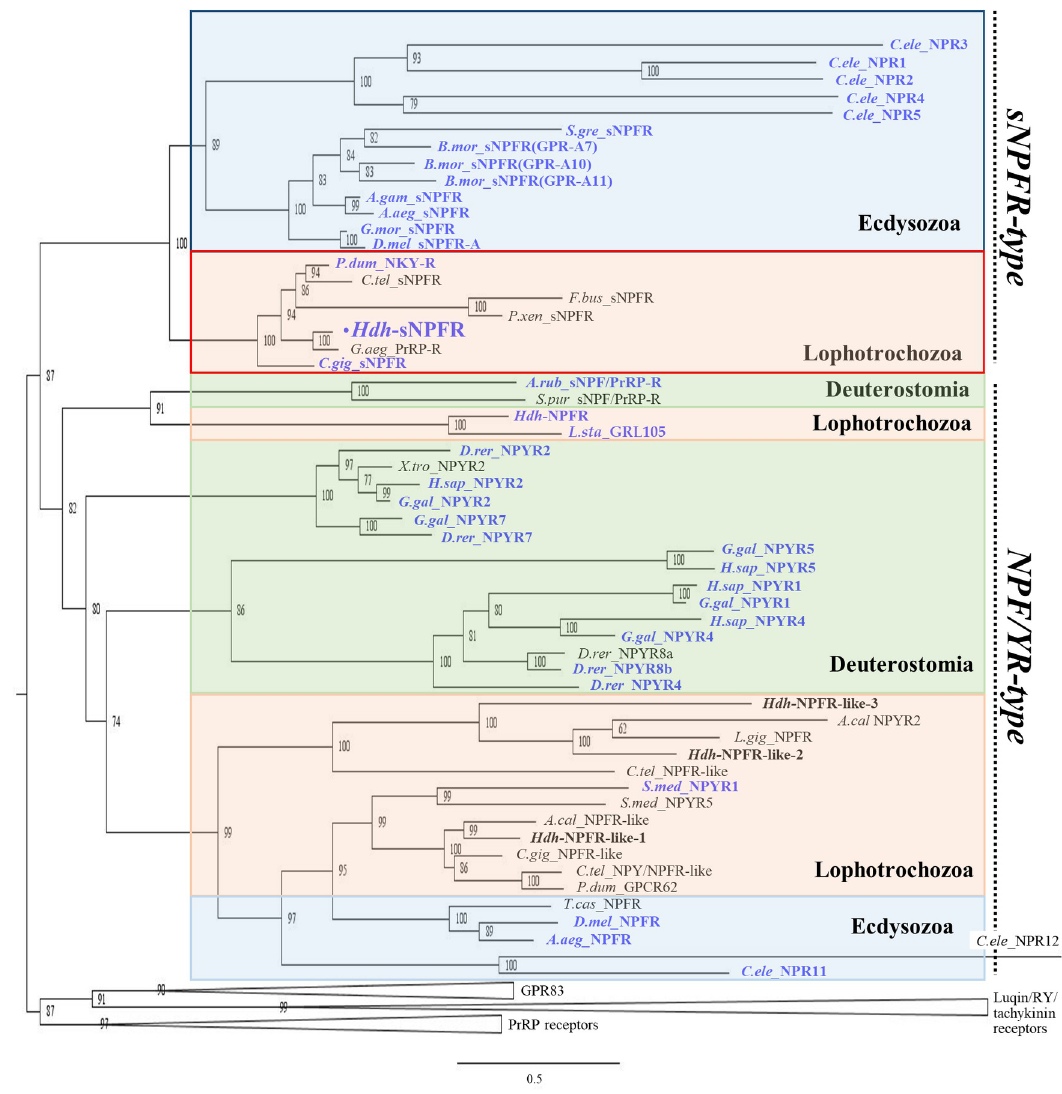
Fig 4. Phylogenetic tree of Hdh-sNPFR with protostome sNPF-type, bilaterian NPF/Y-type, and deuterostome PrRP-type receptors. Luqin/RYamide-type, tachykinin-type, and GPR83-type receptors were used as outgroups (condensed). Amino acid sequences of the receptors (see S2 Table) were aligned and the 215 trimmed residues were used to generate the maximum-likelihood tree using W-IQ server. Ultrafast bootstrap values are given at each branch, and the scale bar indicates amino acid substitutions per site. Deorphanized receptors for which receptor–ligand interactions have been experimentally characterized are colored in